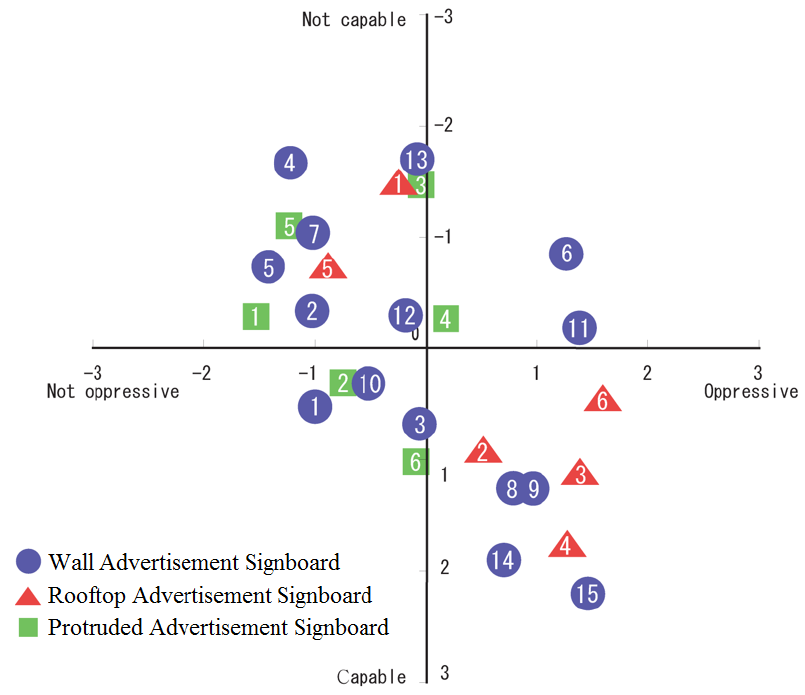
Figure 8. Scatter diagram of correlations based on the oppressive feeling and capacity factor values. Table 9. Correlations between oppressive feelings and each factor. (** : p<0.01).